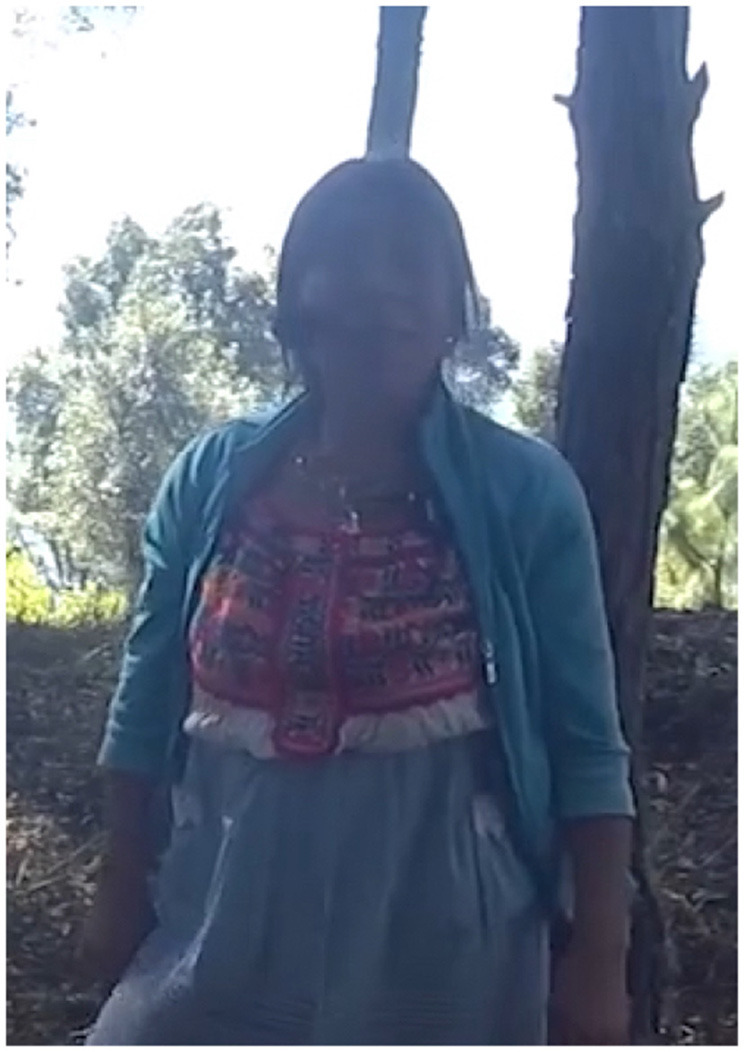
Activity scale [target: Peak of kyqyaC kcheqB].